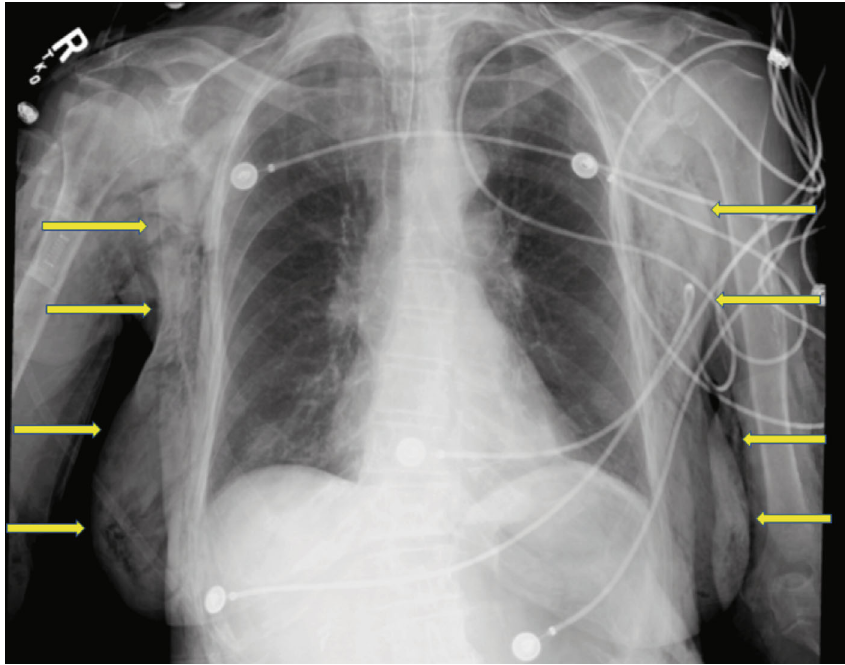
Figure 1: CXR with arrows demonstrating severe subcutaneous